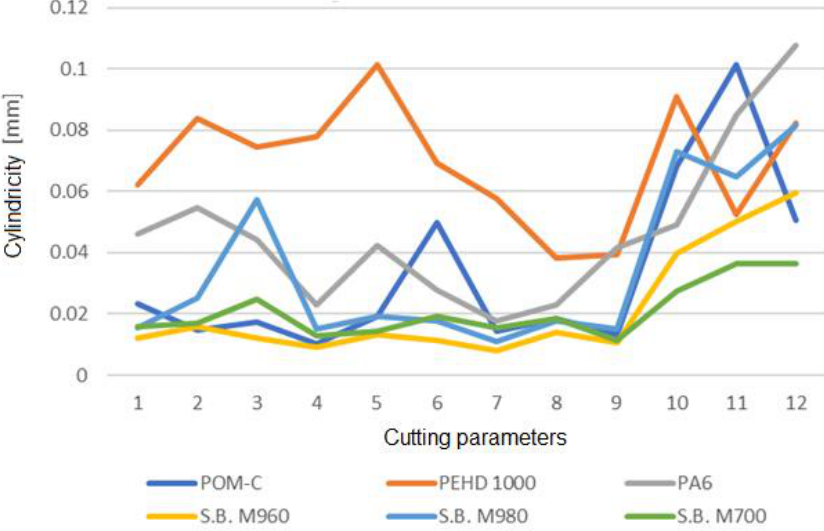
Figure 10. Cylindricity according to material and cutting parameters.